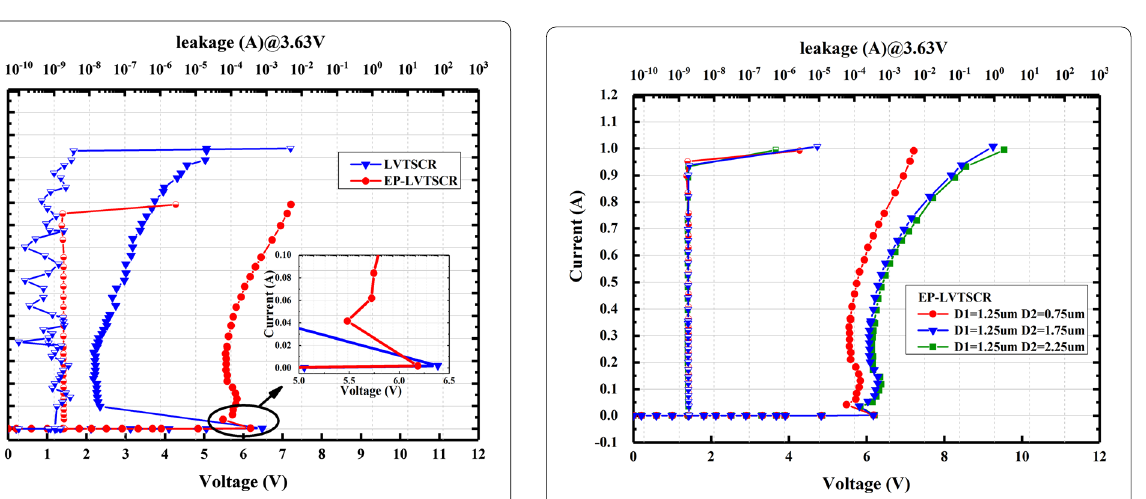
Fig. 7 Measured TLP I–V and leakage currents of EP-LVTSCR with three different